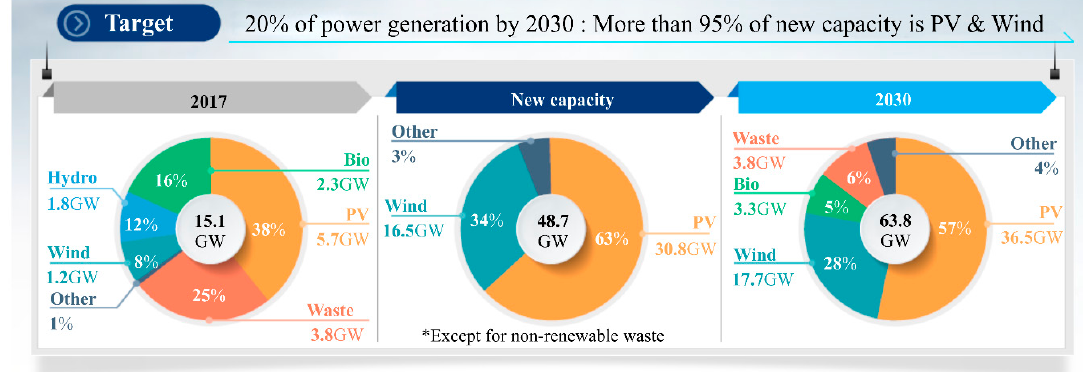
Figure 1. Cumulative installed capacity of offshore wind power in Europe.